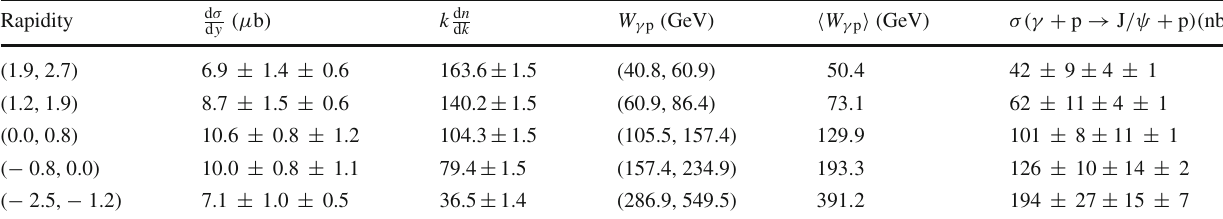
( (cid:7) W γ p (cid:8) ) and the extracted cross section σ(γ + p → J /ψ + p ) . The first uncertainty in the cross sections is statistical, the second is sys- √ s NN = 5 . 02 tematic and the third comes from the uncertainty in the photon